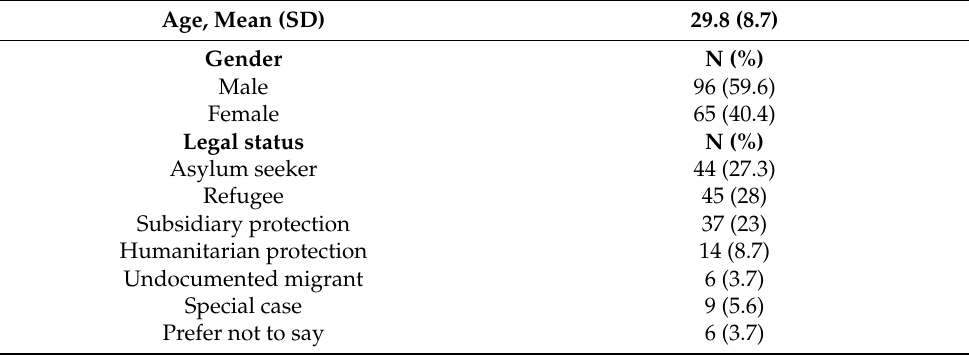
Table 2. Sociodemographic characteristics of participants.